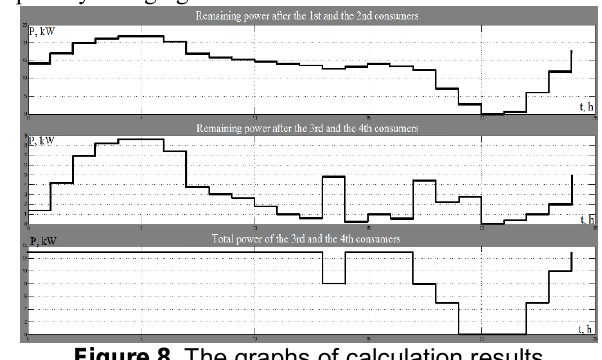
Figure 8. The graphs of calculation